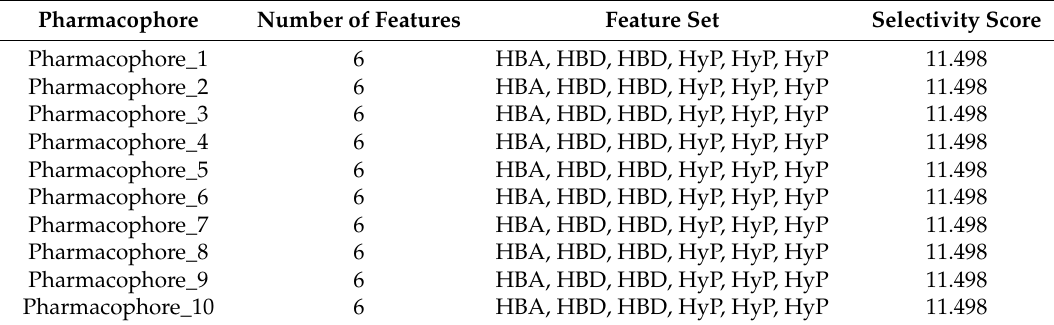
Table 3. Receptor-based pharmacophore